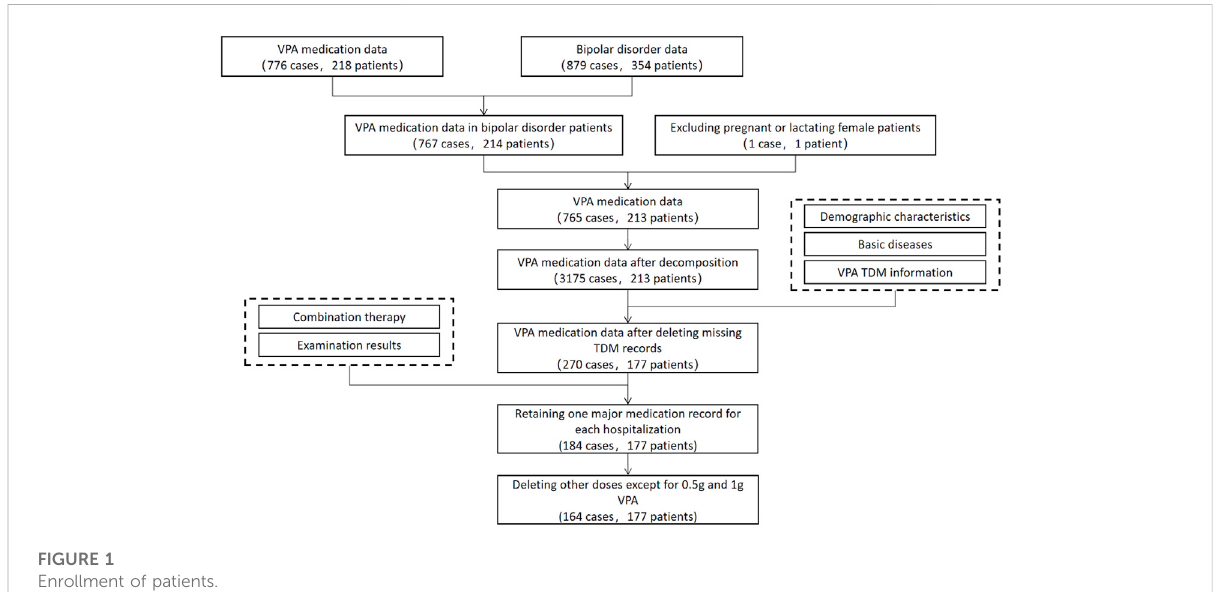
FIGURE 1 Enrollment of patients.